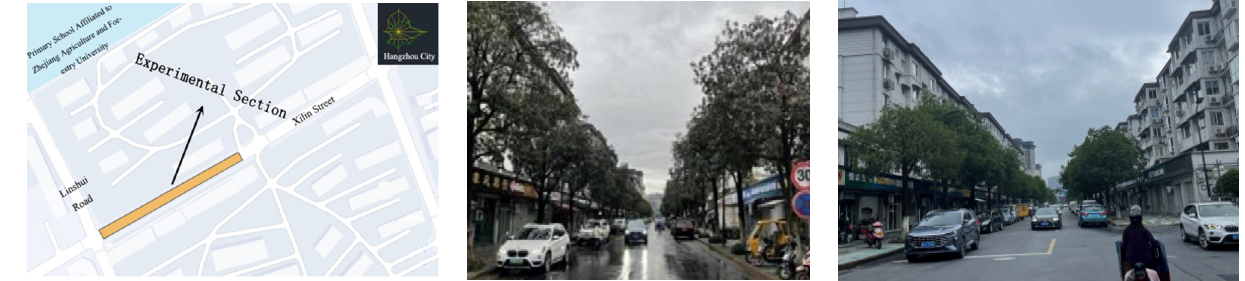
Figure 1. Study Area.